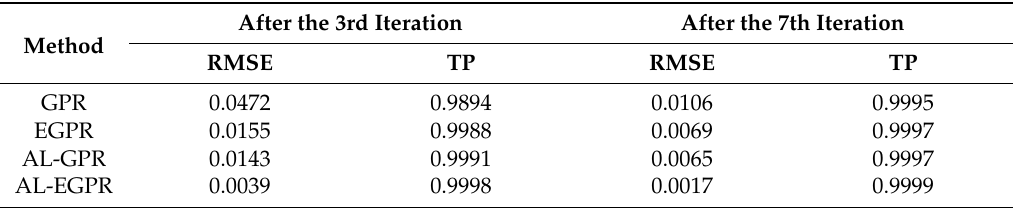
Figure 10. Bayesian information criterion (BIC) performance against variation of Gaussian components. Table 3. Prediction performance indicators of di ff erent modelling methods after the 3 rd iteration and the 7 th